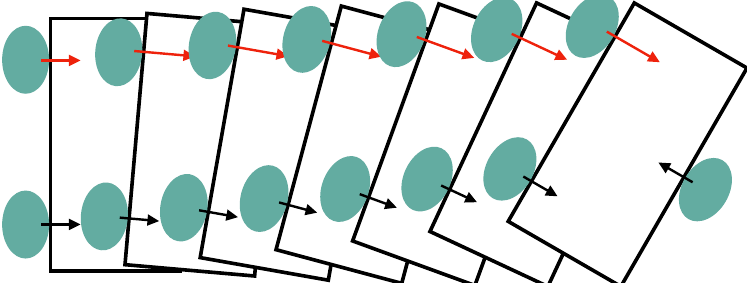
Figure 8. An example of how a rotation can be achieved with a tripod grasp when relying on a master–slave control approach. In this case, the index finger is the master, increasing the amount force applied in its normal contact direction. This force increase forces the object to pivot around the center of the grasp while the remaining fingers keep the object stable throughout the